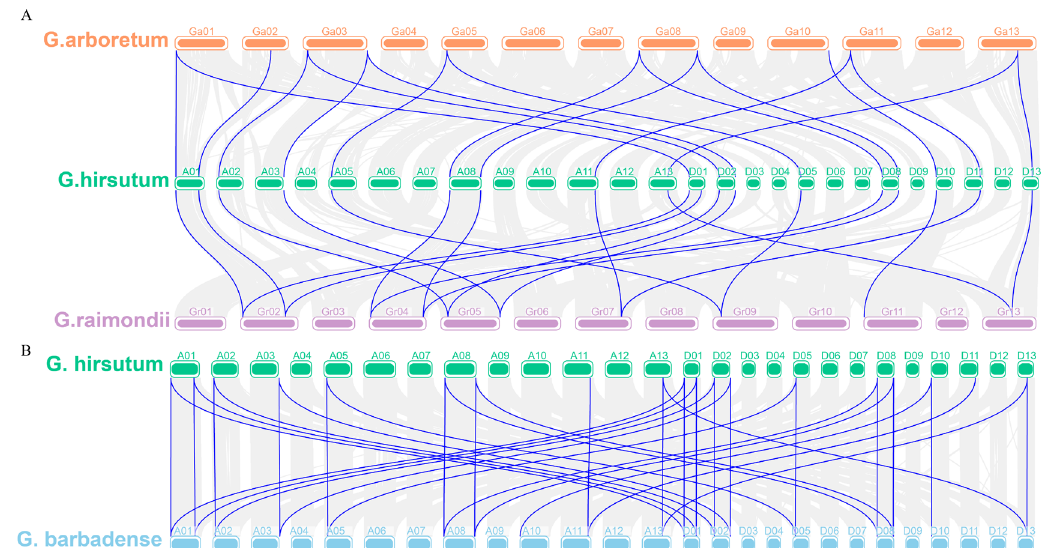
Figure 4. The synteny analysis of YTH genes in four cotton species. ( A ) The collinear relationship between Gossypium arboreum , Gossypium raimondii , and Gossypium hirsutum . ( B ) The collinear relationship between Gossypium hirsutum and Gossypium barbadense . Blue lines represent syntenic YTH gene pairs. Grey lines indicate collinear block.